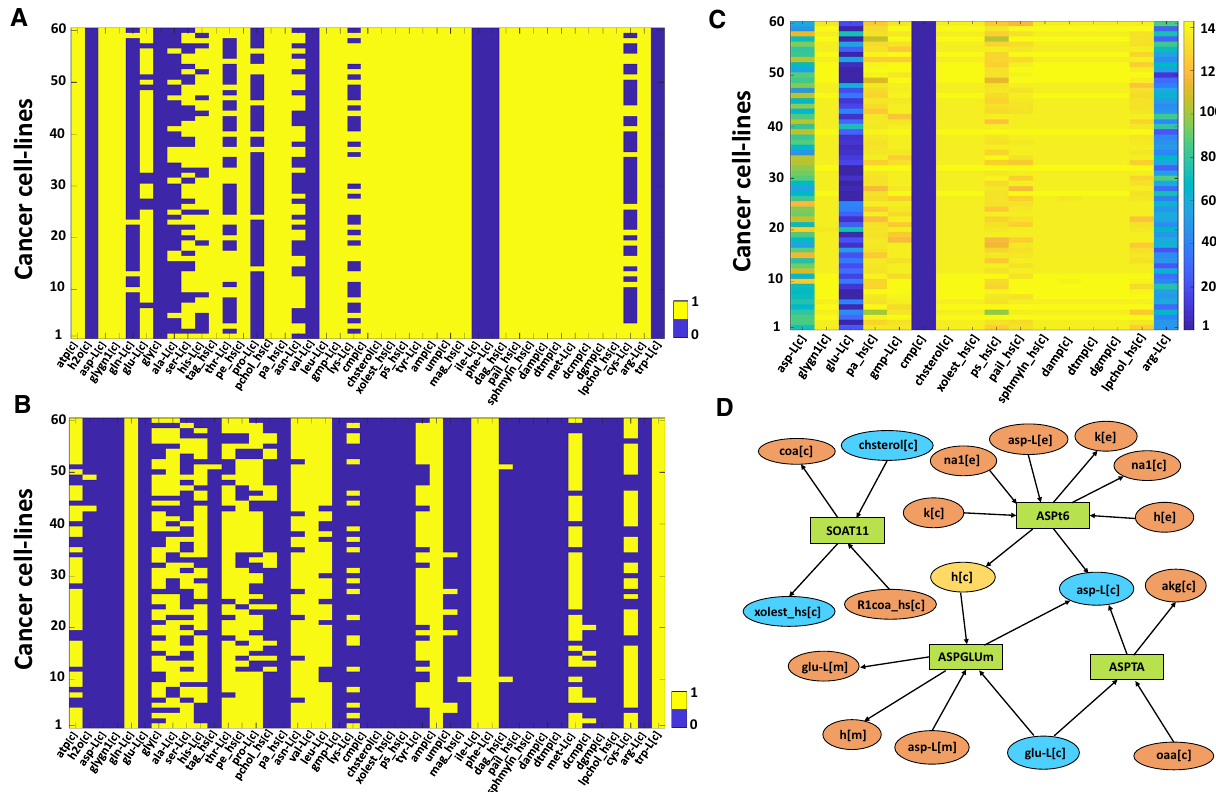
Figure 4. Biomass metabolites affected by the 143 growth reducing genes and 1488 non-effecting genes. Reduction in production fluxes for each individual biomass metabolites were captured in the gene knockout condition. ( A ) Represent the production flux are twofold decreased or not for any 143 genes and ( B ) represents the case for 1488 genes. We gave value 1 if the production flux of a metabolite is decreased in at least one gene knockout condition across each cell-lines, otherwise, the value remains zero. For 16 metabolites, all values are zero across the 60 cancer cell-lines in ( B ) but there are non-zero values in ( A ). ( C ) The number of genes among the set of 143 growth reducing genes whose knockout shows at least twofold reduction in the production fluxes for each of the 16 metabolites. ( D ) A bipartite network that represents the connection between L-Aspartate, L-Glutamate, cholesterol and cholesterol ester. Rectangular and ellipse-shaped boxes indicate the reaction and metabolite respectively and the arrow shows the flow of the flux.